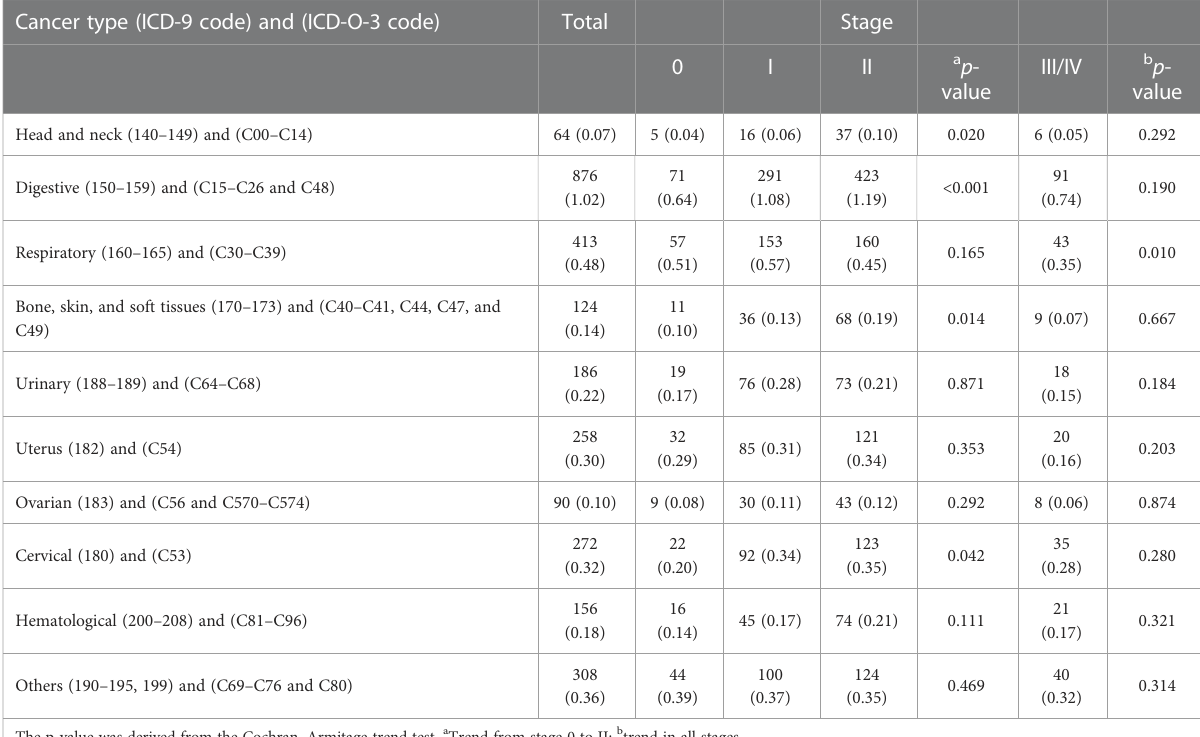
TABLE 2 Second cancer types in patients with different stages of breast